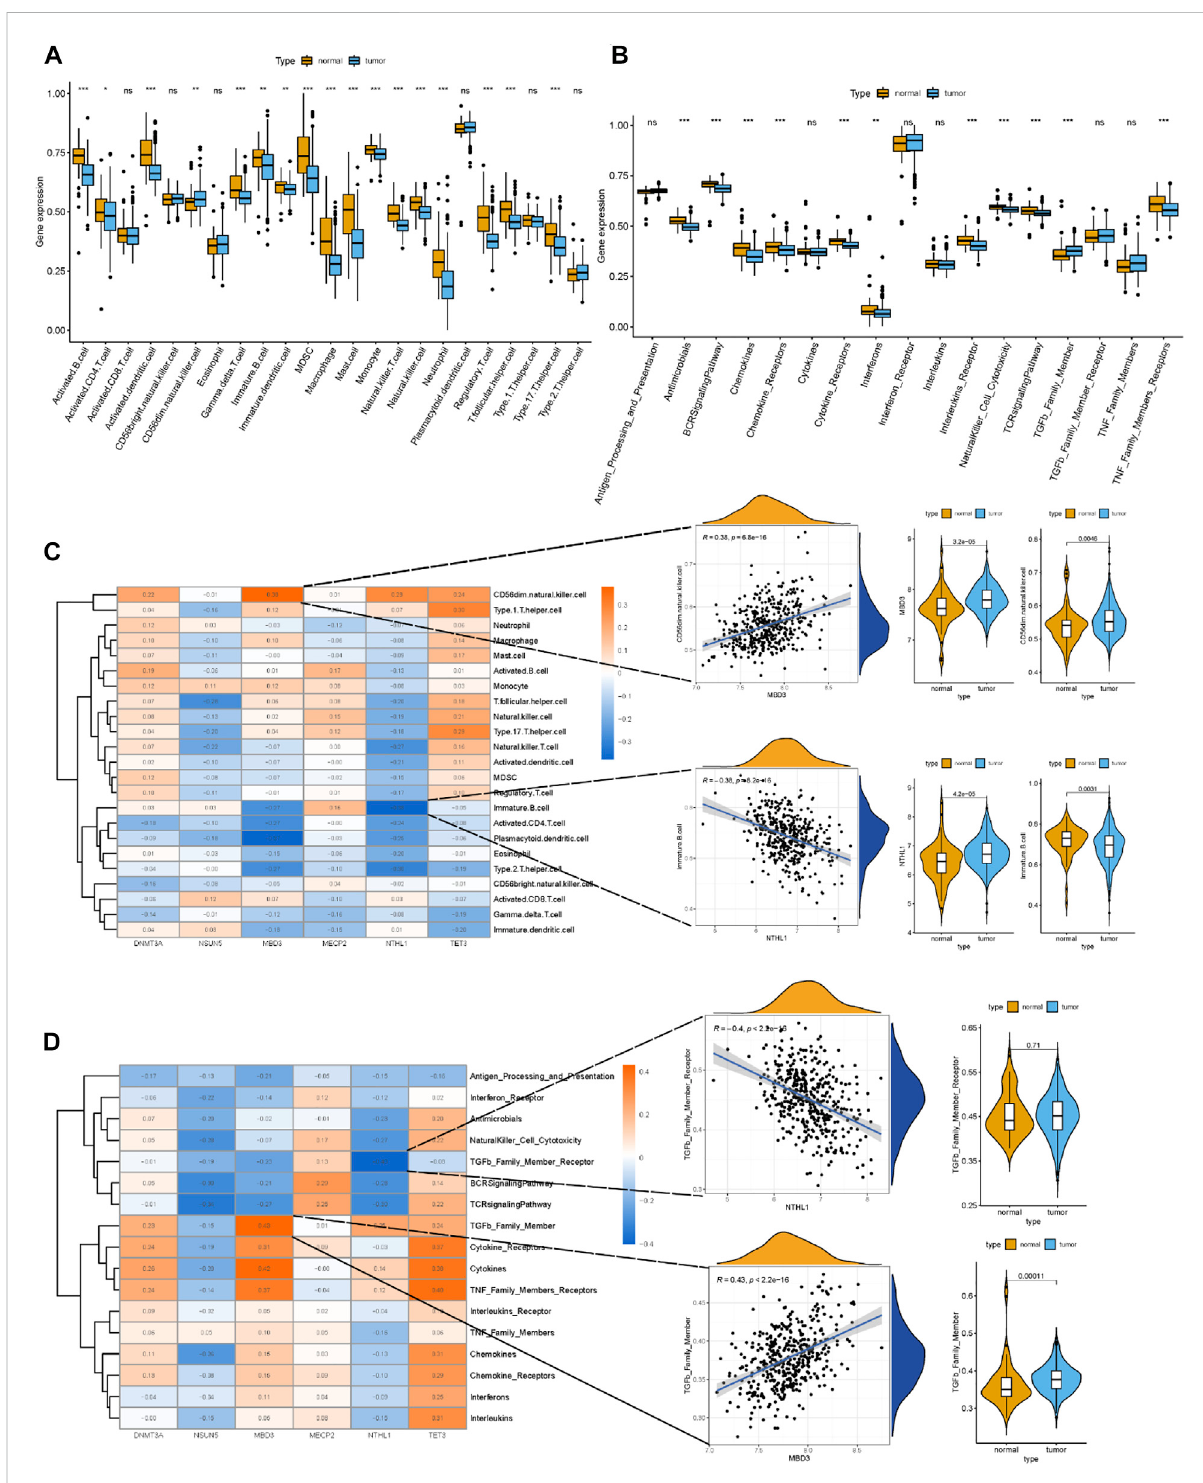
FIGURE 3 Relationship between m 5 C regulators and immune characteristics of MM. (A) Boxplot of the abundance of 22 immunocytes in the healthy and MM samples. (B) Boxplot of the abundance of 17 immune response reactions in the healthy and MM samples. (C) Heatmap showing correlations between the six m 5 C regulators and 22 immunocytes. The scatterplots showed the positive and negative correlations between m 5 C regulators and immunocytes. The expression data were presented in a violin box plot (right panel). (D) Heatmap showing correlations between the six m 5 C regulators and 17 immune response reactions. The scatterplots showed the positive and negative correlations between the m 5 C regulators and immune response reactions. The expression data were presented in a violin box plot (right